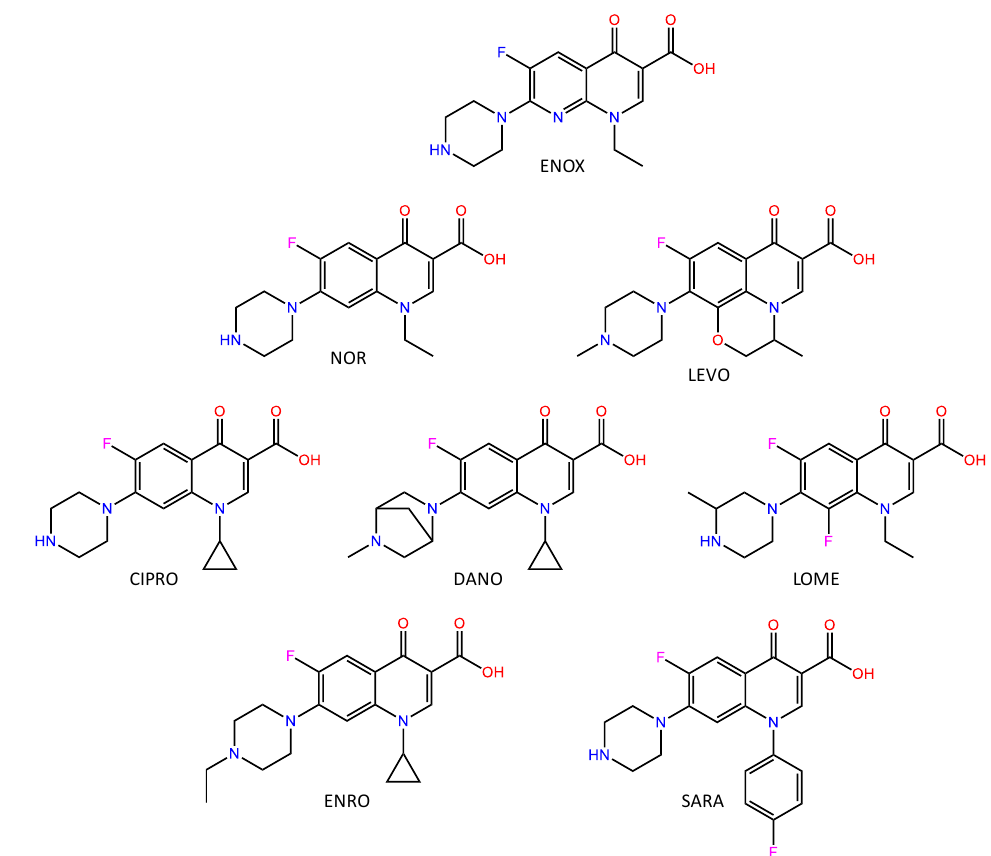
Figure 1. Chemical structures of the template molecule (ENOX) and the target FQs.